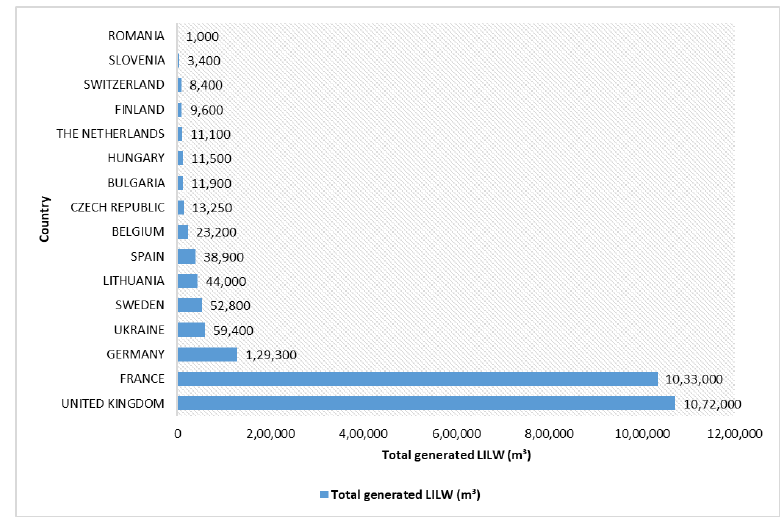
Figure 3. Total generated LILW in different